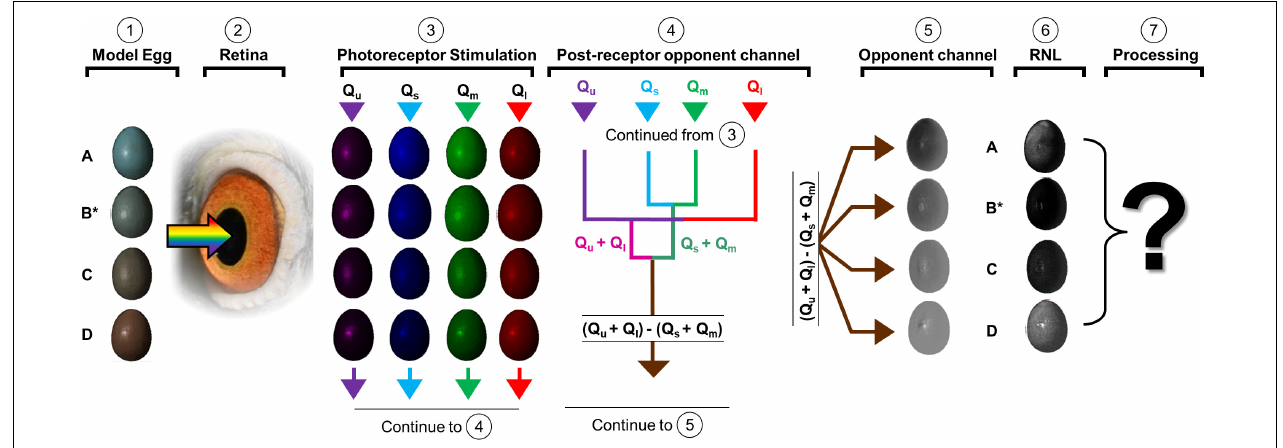
FIGURE 1 | The pathway to perceived color variation involves the capturing of light reflected by stimuli such as model eggs (column 1) by the retina (column 2), the resultant photoreceptor stimulation (column 3), and the formation and transmission of an opponent signal to the brain (column 4). We can make predictions about perceived egg color that likely result from these opponent channels (column 5), possibly differing from the predictions of the receptor noise-limited (RNL) model (column 6). Ultimately, we have much to learn about the cognitive processes that hosts use to act on color information (column 7). Here we show model eggs (labeled A-D in column 1), where egg B is considered an “own” egg template (to which others will be compared, indicated with asterisk). The inset eggs under “photoreceptor stimulation” represent the quantum catches (see section “Color Reception” for details) under standard daylight conditions, following previously published methods (Stevens et al., 2007). The post-receptor processes (columns 4–7) are less well studied in birds, and birds may rely on specific opponent channels that weigh the contribution of specific photoreceptors in distinct ways. We show one such opponent channel (column 5) that is produced based upon the quantum catches of each egg model type (each set of arrows describes the process), when the sign of the signal (positive or negative) and may result in distinct responses to stimuli that differ from our null expectation under the RNL model (column 6, black = 0 JND and white ≈ 5 JND) where each egg is compared against egg B. That perceived color information may then be used via unknown (question mark) higher order processes. Inserted photograph of the avian eye (in column 2) was modified (cropped, flipped, rotated, and vignetted) from “Eyes and eyelids” by PigeonsAreAwesome under the CC BY-SA 4.0